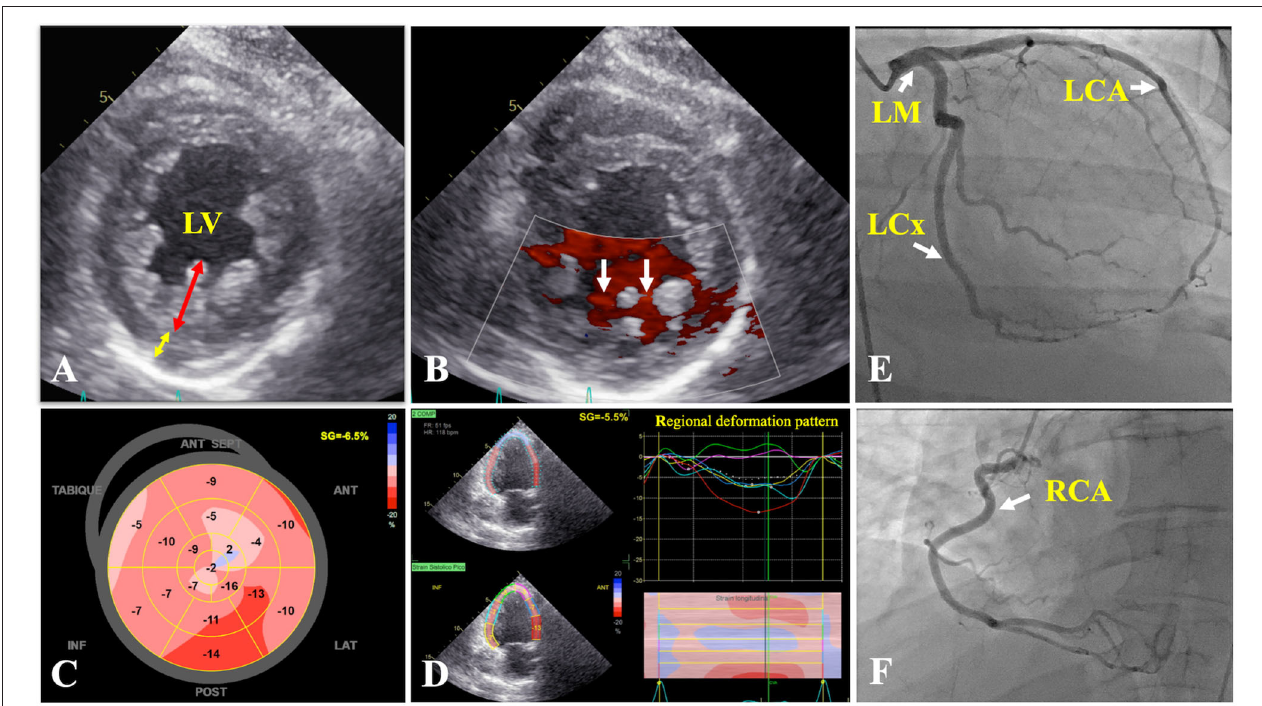
FIGURE 2 | Transthoracic echocardiogram. (A) Parasternal short axis of the mid left ventricle demonstrating two-layer myocardial structure, with a ratio of ticker non-compacted (redline) to thin compacted (yellow line) myocardium > 2 at end-systole in the inferolateral segment. (B) Flow between intertrabecular recesses by intraventricular blood on color Doppler (white arrows). (C) Reduced global longitudinal strain ( − 6.5%). (D) Two-chamber view showing a regional deformation pattern with a markedly decreased myocardial deformation in apical segments (green and purple curves) in comparison to basal segments (red and yellow curves). Coronary angiography: coronary arteries without lesions (E,F) (white arrows). LCA, left coronary artery; LCx, left circumflex coronary artery; LM, left main coronary artery; LV, left ventricle; RCA, right coronary artery.